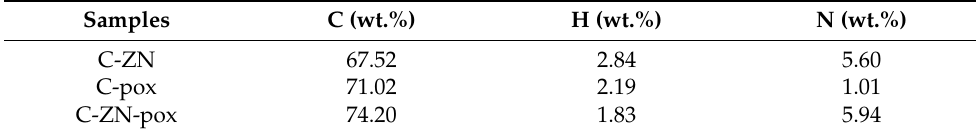
Figure 1. ( a ) SEM images of ( I ) C-pox, ( II ) C-ZN-pox, ( III , IV ) C-ZN; ( b ) thermogravimetric curves of C-ZN, C-pox and C-ZN-pox. Table 1. Element concentrations in the selected activated carbon samples.